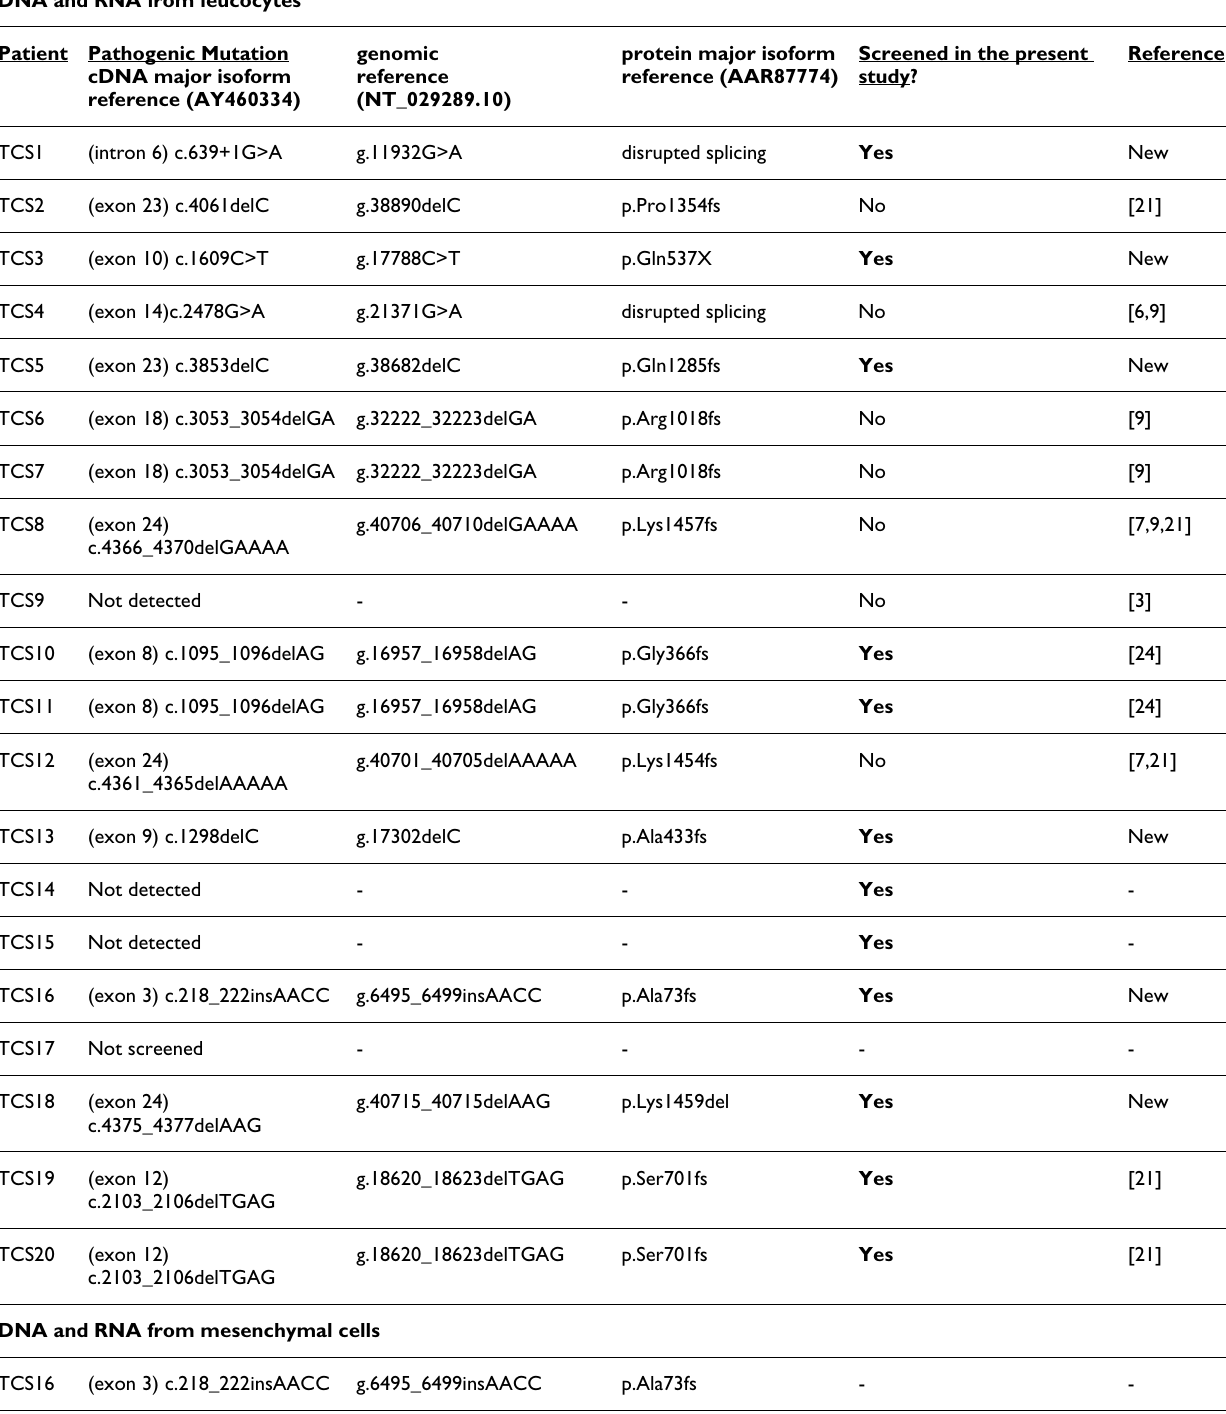
Table 1: Pathogenic mutations of TCS patients analyzed for TCOF1 expression: DNA and RNA from leucocytes Patient Pathogenic Mutation cDNA major